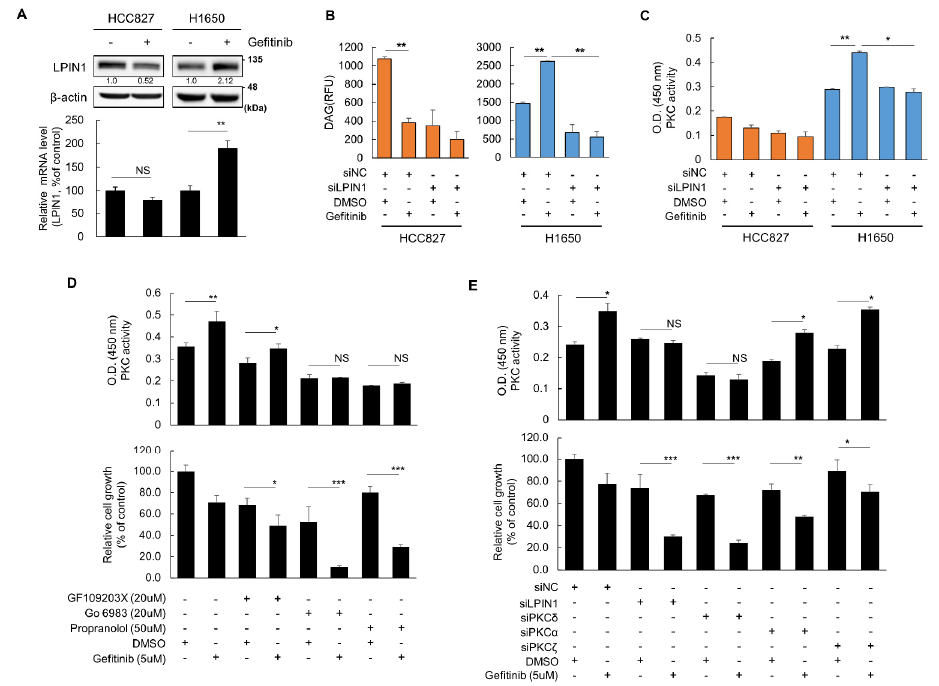
Figure 2. LPIN1 promotes PKC δ activation by increasing DAG production upon gefitinib treatment in TKI-resistant cells. ( A ) The effect of gefitinib treatment on LPIN1 expression was measured. The mRNA and protein levels in the HCC827 and H1650 cells treated or untreated with gefitinib were determined via qRT-PCR or western blotting, respectively. ( B , C ) HCC827 and H1650 cells were transfected with siLPIN1 or siControl (siNC). ( B ) DAG levels or ( C ) total PKC activity was deter- mined after gefitinib (5 μ M) or DMSO treatment for 24 h. ( D ) H1650 cells were pretreated with PKC α , PCK β , PKC δ , or PKC γ inhibitors (GF109203X (20 μ M S7208) or Go 6983 (20 μ M S2911)) or LPIN inhibitor (50 μ M propranolol) for 2 h, treated with 5 μ M gefitinib, and subjected to PKC ac- tivity and cell counting assays. ( E ) H1650 cells were transfected with siRNAs for LPIN1, PKC α , PKC δ and PKC ζ individually or as a mixture, treated with gefitinib (5 μ M) or DMSO for 72 h, and subjected to PKC activity and cell counting assays. Values are the mean ± SD of three independent experiments. Statistical significance was determined by ( A , D , E ) Student’s t -test or ( B , C ) two-way ANOVA (*, p < 0.05; **, p < 0.01; ***, p < 0.001; and NS, not significant). Knowing that DAG induces PKC activation, we compared the relationship between LPIN1 expression and PKC activation in gefitinib-sensitive and gefitinib-resistant lung cancer cells. Consistent with the result showing a higher content of DAG in H1650 than in HCC827 cells (Figure 2B), the basal level of PKC activity was higher in the gefitinib-re- sistant H1650 cells. Upon gefitinib treatment, PKC activity increased only in H1650 cells, similar to the increase in DAG levels, and LPIN1 depletion abrogated the induction of PKC activation (Figure 2C). This implies that LPIN1 is a key factor responsible for altered PKC activation in gefitinib-resistant cancer cells. To assess the potential association between altered PKC activation and gefitinib re- sistance, we examined the relationship between PKC activity and cell viability using phar- macological and RNAi approaches. Although treatment with PKC inhibitors suppressed basal PKC activity, only the PKC inhibitor Go 6983 completely aborted the induction of PKC activation following gefitinib treatment (Figure 2D, upper panel). At the same time, the sensitivity of H1650 cells to gefitinib remarkably increased when gefitinib was co- treated with Go 6983 (Figure 2D, lower panel), suggesting that PKC δ is responsible for gefitinib-dependent PKC activation and drug resistance in H1650 cells. The LPIN inhibitor propranolol treatment also aborted the induction of PKC activation and significantly in- creased gefitinib sensitivity in H1650 cells following gefitinib treatment (Figure 2D). These